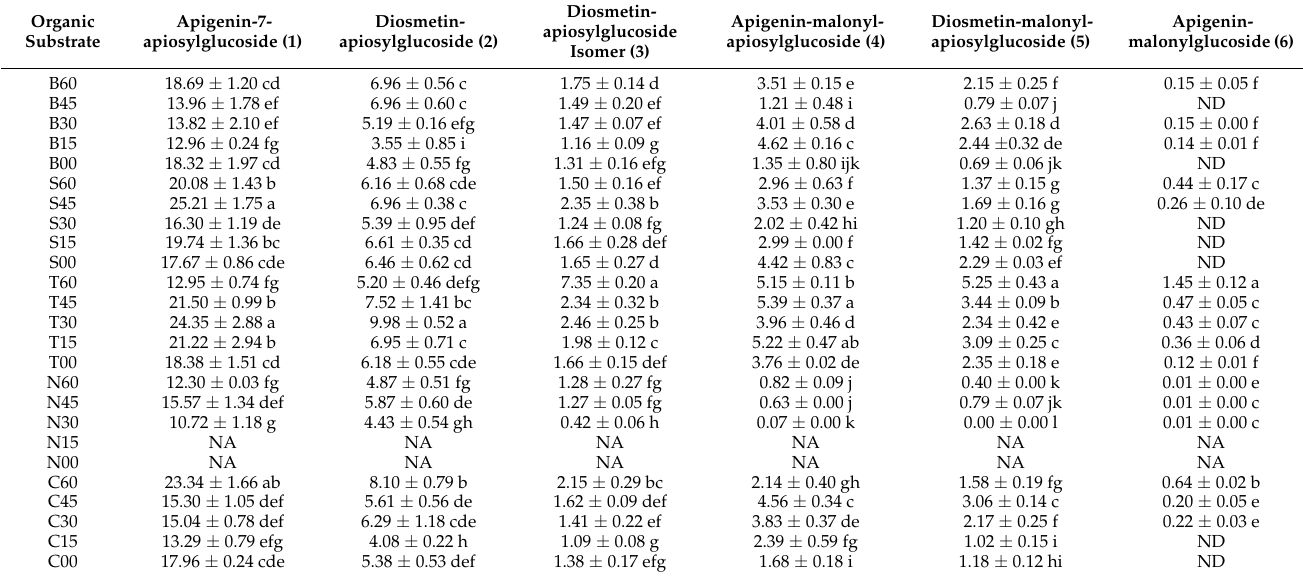
Table 4. Individual flavonoids in parsley grown on different organic substrates 1 . Organic